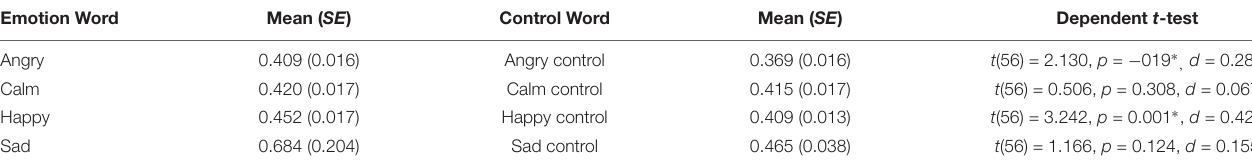
TABLE 2 | Dominance ratios for each of the four emotion categories and respective controls for Experiment 1. Emotion